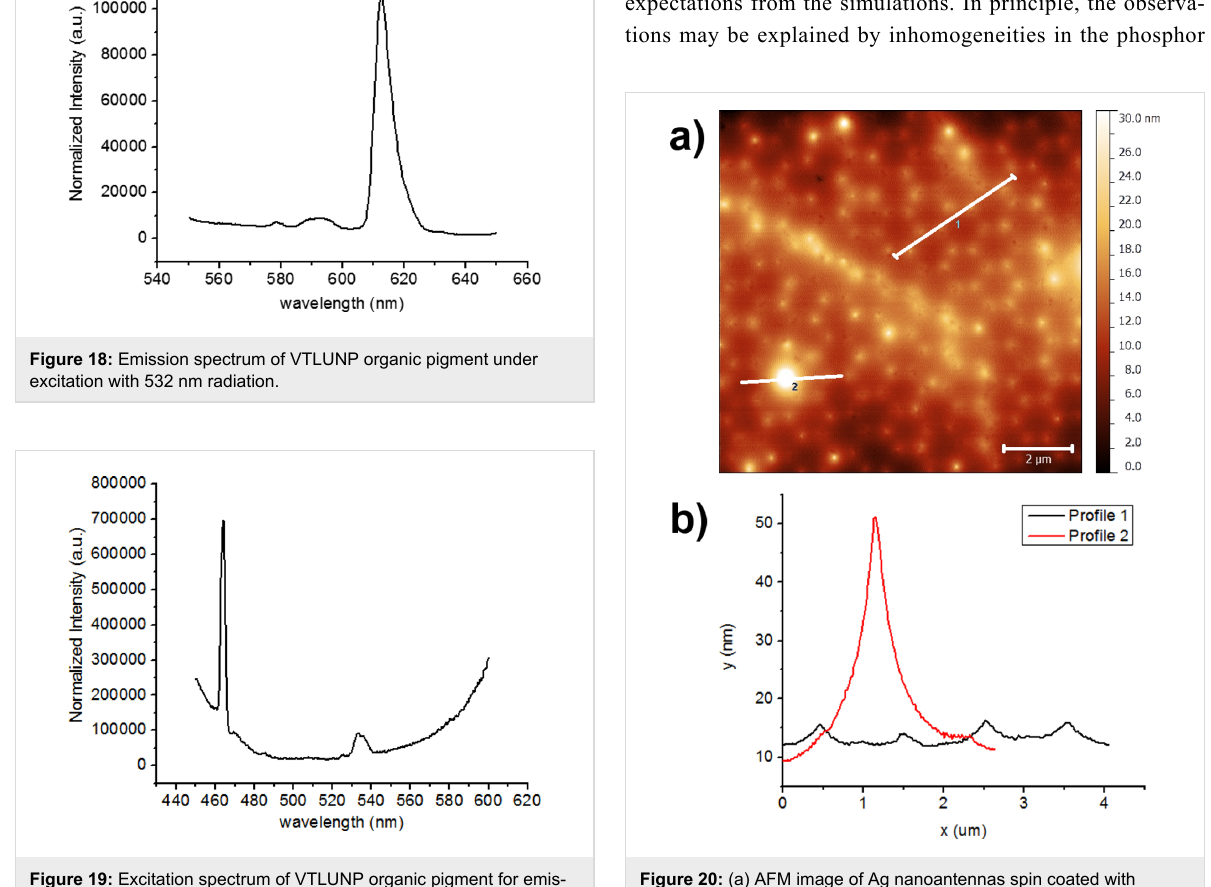
Figure 19: Excitation spectrum of VTLUNP organic pigment for emis- sion at 614 nm.